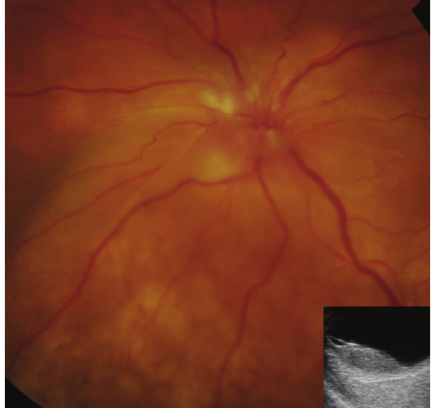
Figure 2: Fundus photograph of the left posterior pole: multiple creamy-coloured choroidal lesions with fine retinal pigment epithe- lial mottling and optic disc oedema with inferior margins obscured by the exudative retinal detachment. Associated with nerve fibre layer ischaemia. Inset: B-scan ultrasound demonstrating elevated choroidal lesions and associated serous retinal